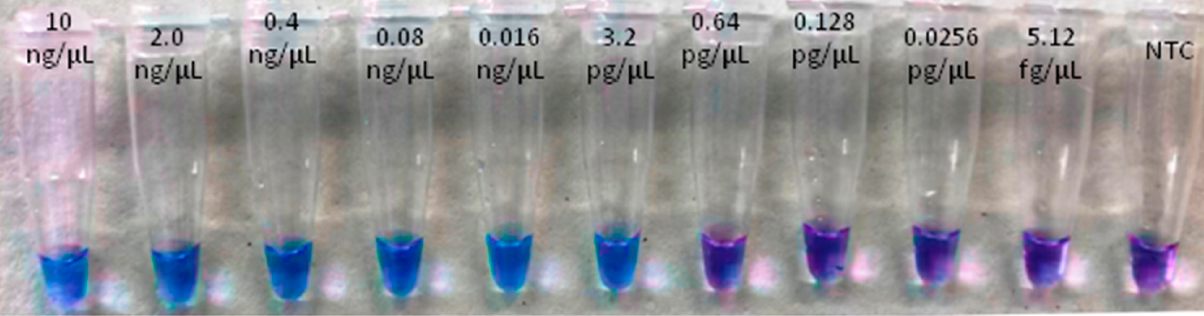
Figure 5. LoD assay of Visual LAMP based on artificial DNA from WTB frass using serial 1:5 dilutions (from 10 ng/µL to 5.12 fg/µL).